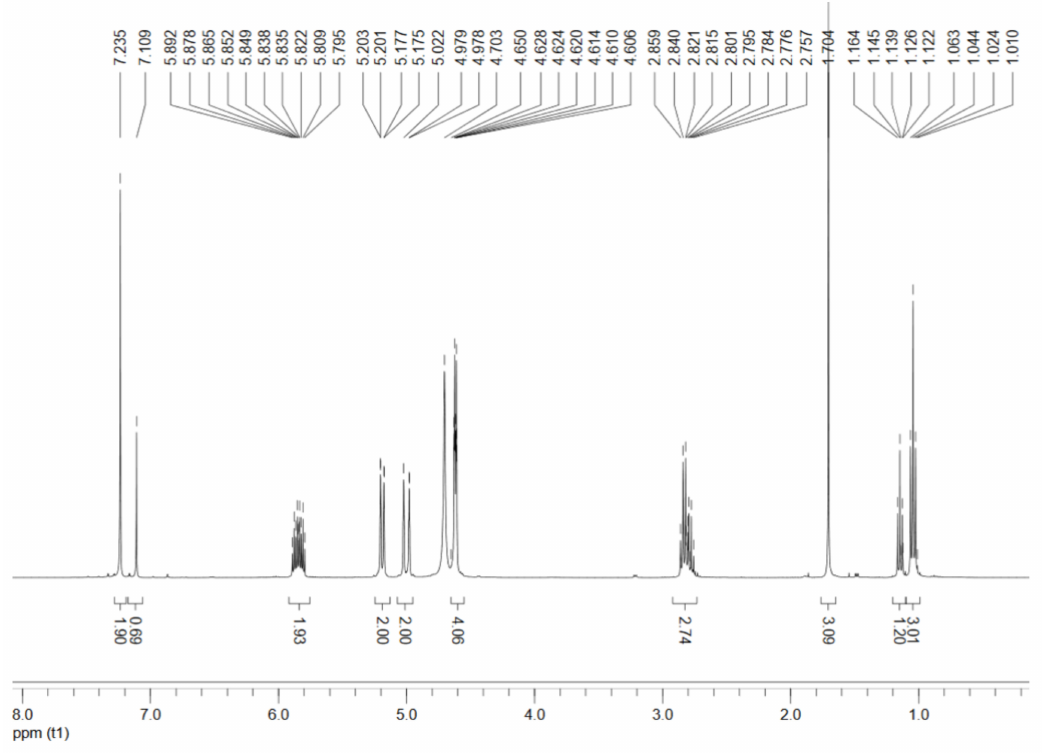
Figure 2. 1 H Nuclear Magnetic Resonance (H-NMR) spectra of the synthesized 1,3-diallyl-2- ethylimidazolium